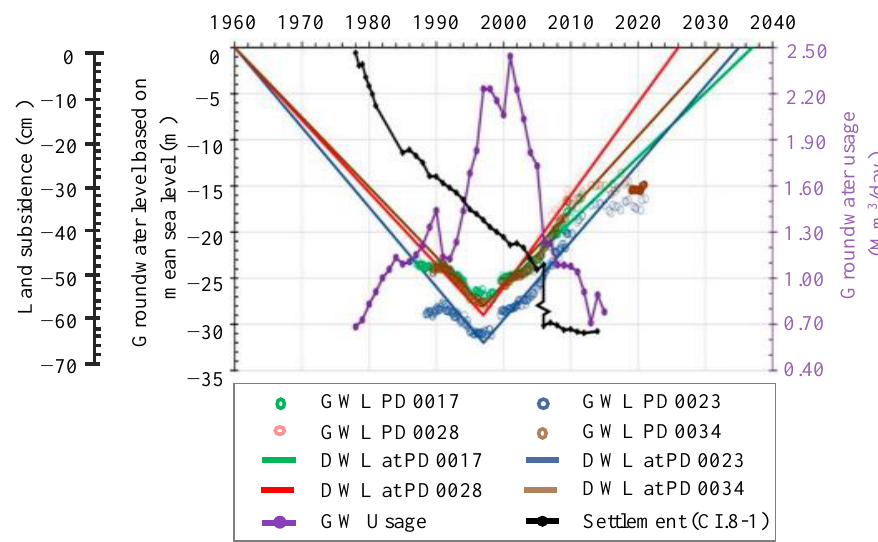
Figure 1. Changes in groundwater level and land subsidence due to groundwater pumping.